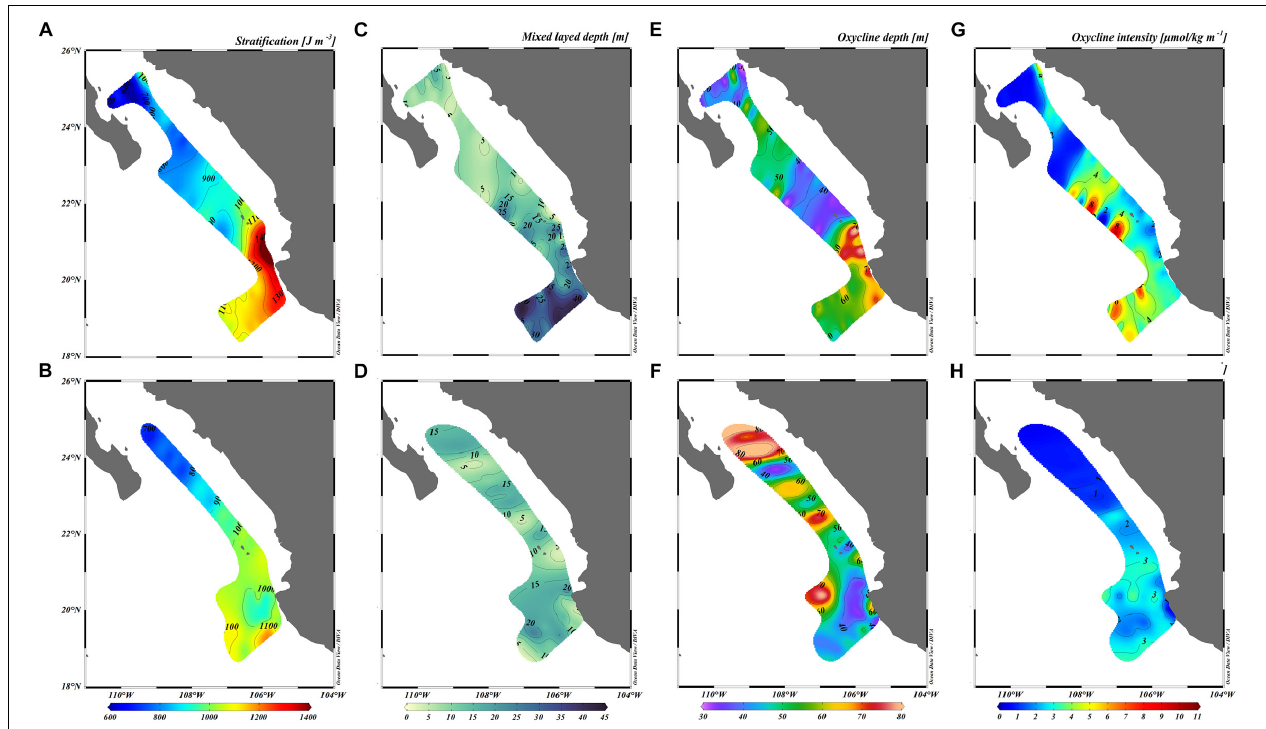
FIGURE 9 | Isosurfaces of stratification (A,B) calculated for the first 300 m, mixed layer depth (C,D) , oxycline depth (E,F) , and oxycline intensity (G,H) . Top figures, June 2015; bottom figures, March